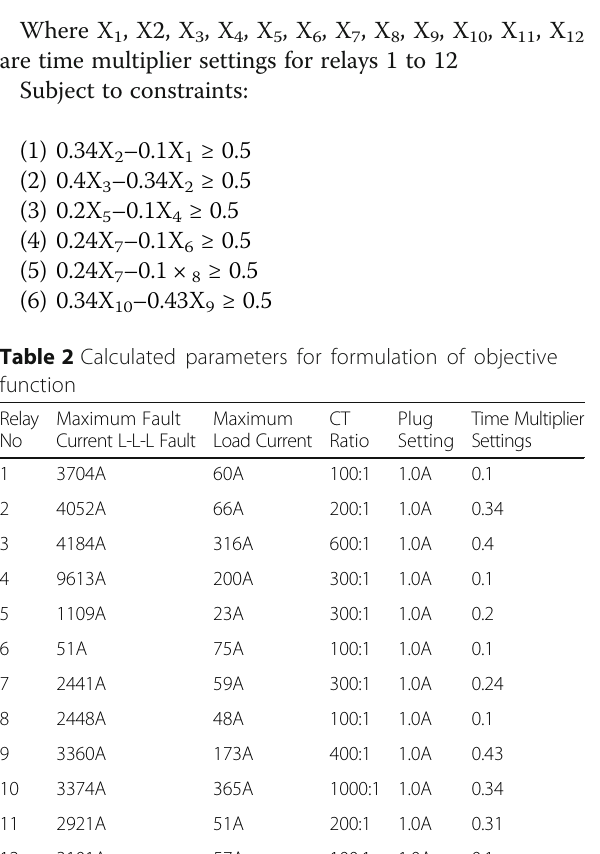
CT Plug Time Multiplier Ratio Setting